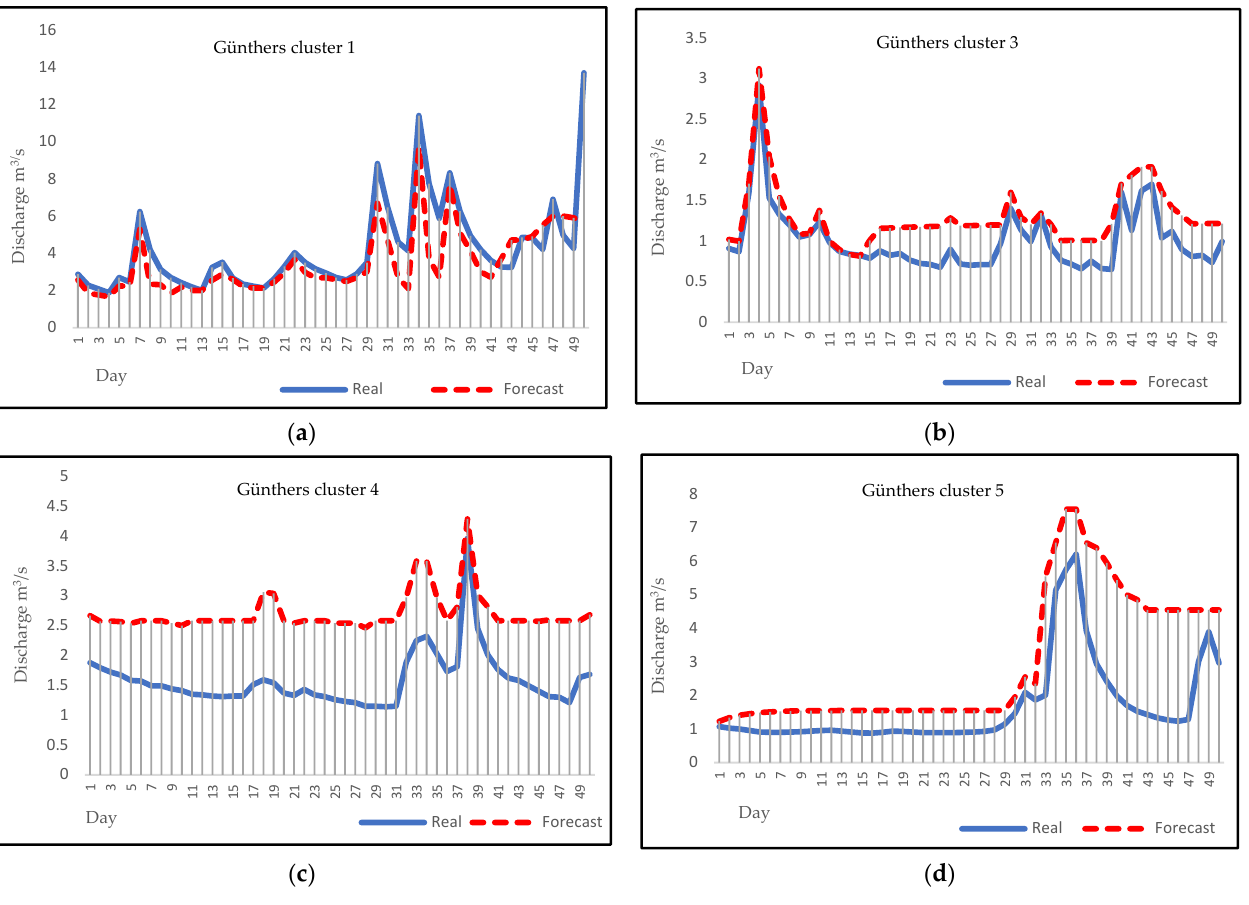
Figure 7. ( a ) Forecasting plot for Günthers cluster 1; ( b ) forecasting plot for Günthers cluster 3; ( c ) forecasting plot for Günthers cluster 4; ( d ) forecasting plot for Günthers cluster 5.